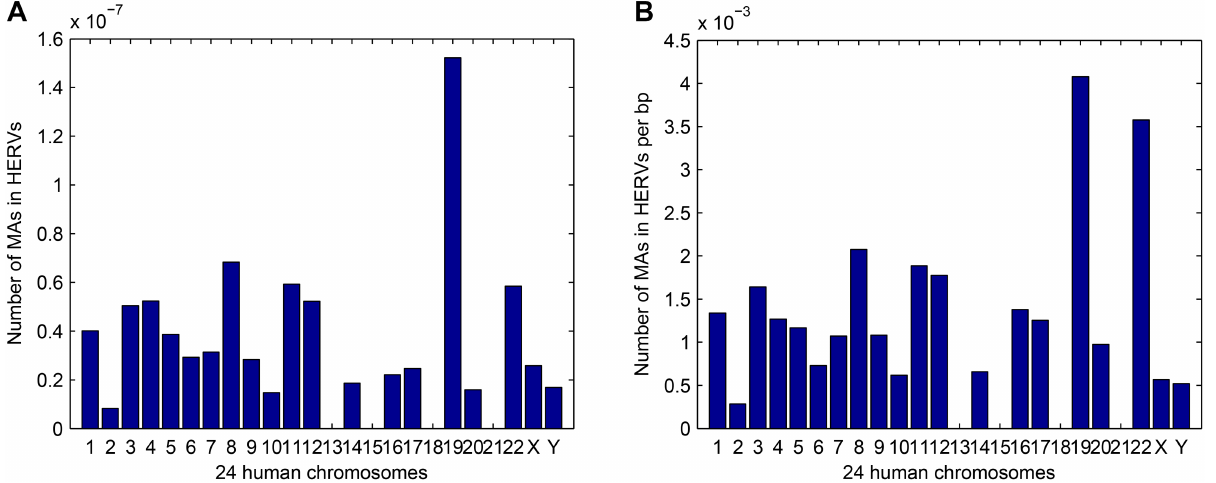
Fig 3. Distribution of MAs. (A) The number of MAs in HERVs of the 24 humanchromosomes. (B)The number of MAs per bp in HERVs of the 24